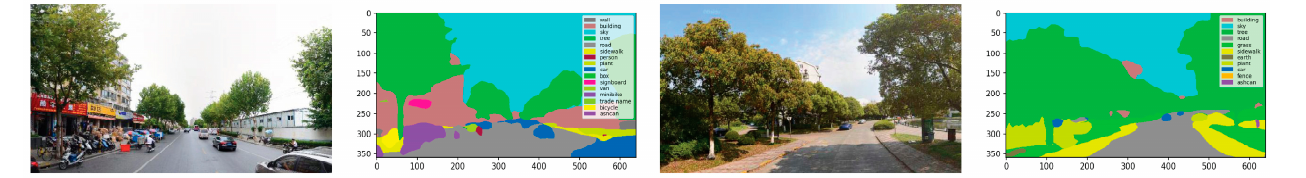
Figure 2. Example of CV parsing raw inputs and results.